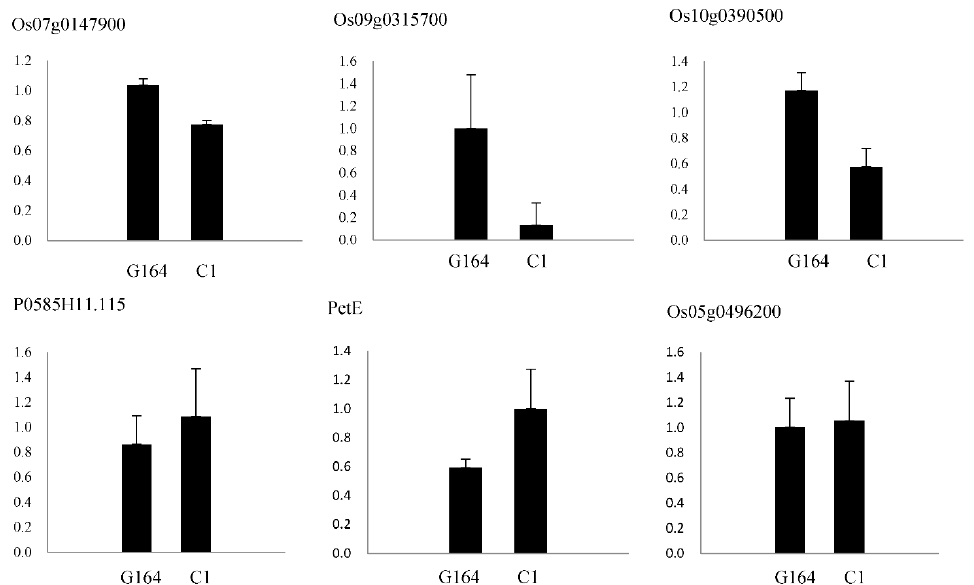
Figure 7. Expression analysis of nine genes in leaves of C1 and G164 using real-time PCR. Note: Os07g0147900: ferredoxin—NADP + reductase (petH); Os09g0315700: phosphoenolpyruvate car- boxylase (ppc); Os10g0390500: alanine transaminase (GPT); P0585H11.115: glutamate-glyoxylate aminotransferase (GGAT); PetE: plastocyanin (petE); Os05g0496200: phosphoglycerate kinase